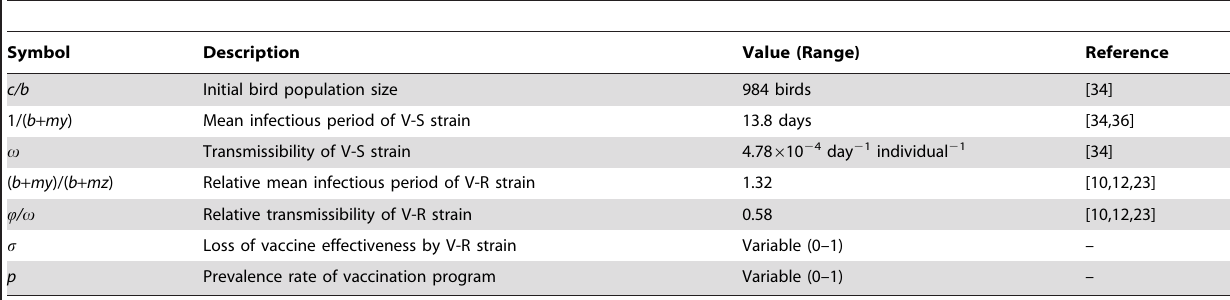
Table 1. Description of physical characteristics, transmission, infectious, and vaccination parameters of the model with their baseline values and ranges used for simulations.